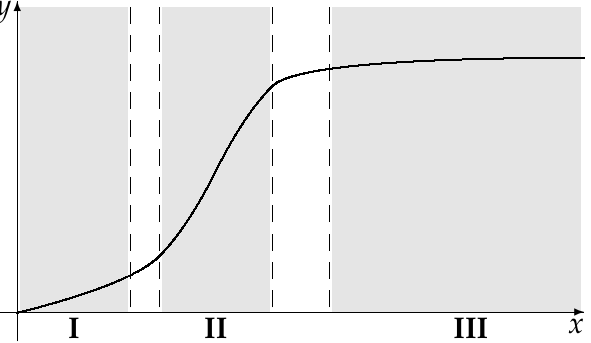
Figure 6. Fragment of the graph of the life cycle of robotization of agriculture: x —time; y —the level of robotization (for example, the volume of production of agricultural robots, the number of imported robots, the number of robots working in agriculture by the time x , etc.); (I) implementation stage; (II) stage of growth; (III) stage of